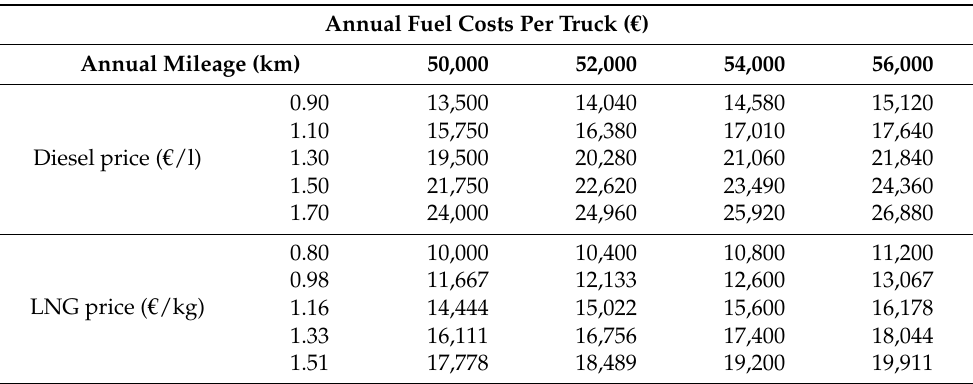
Table 9. Annual fuel costs for diesel and LNG